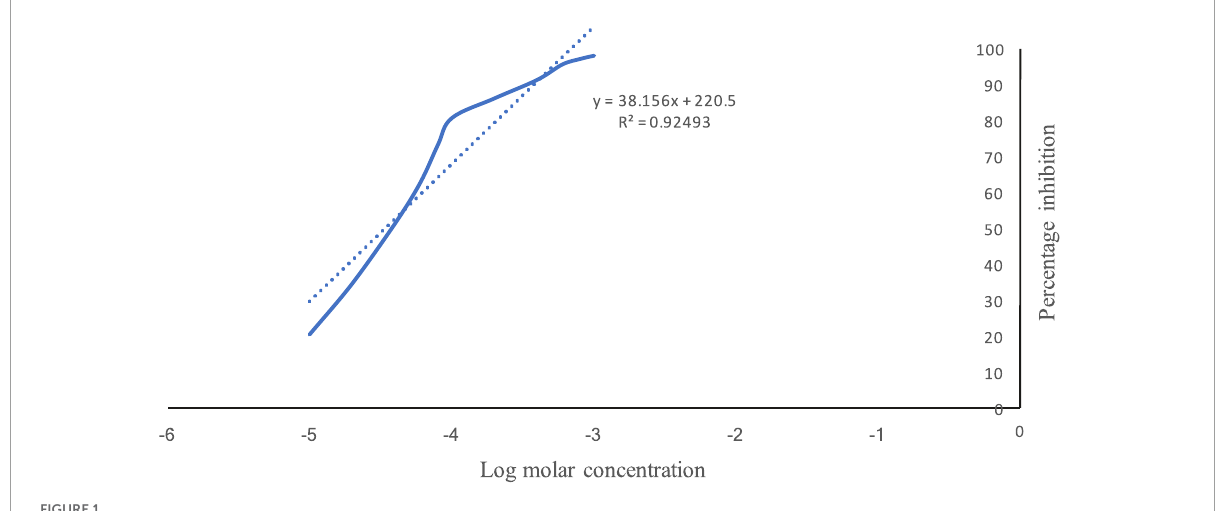
FIGURE1 Percentage inhibition of acetylcholinesterase by vanillin. Solid line shows the % inhibition of AChE by vanillin v/s log molar concentration. Dotted line shows the regressed line.